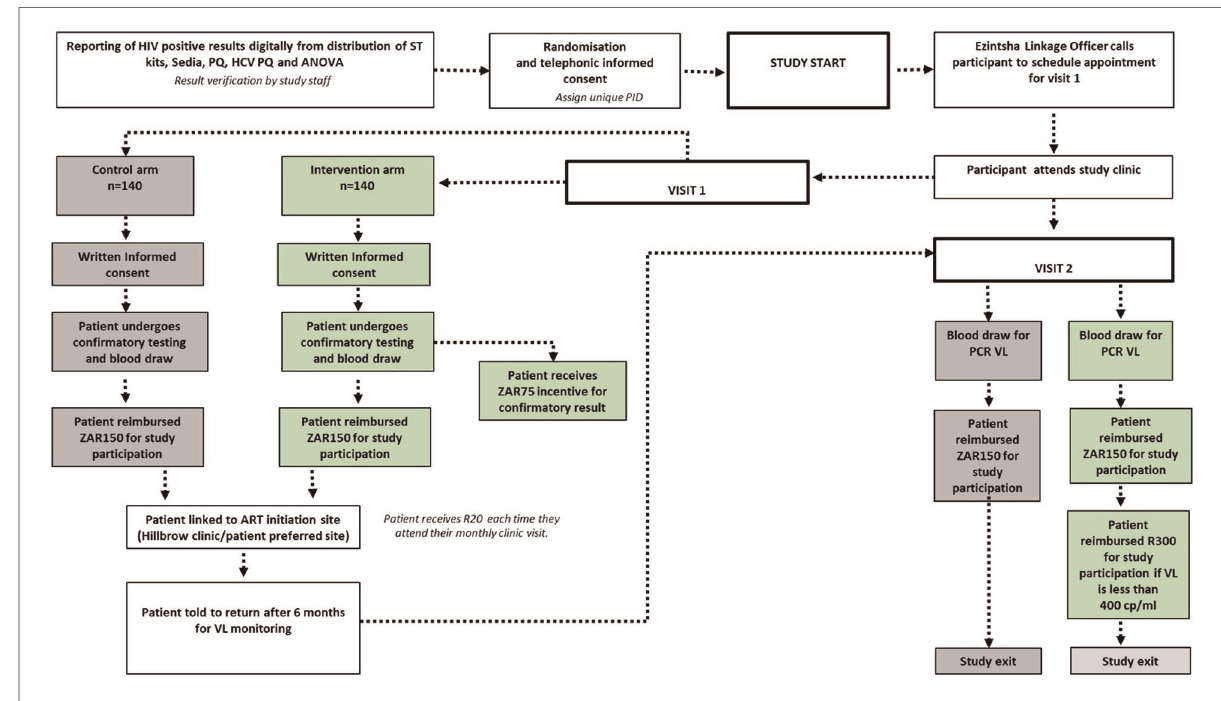
FIGURE 1 Study design work fl